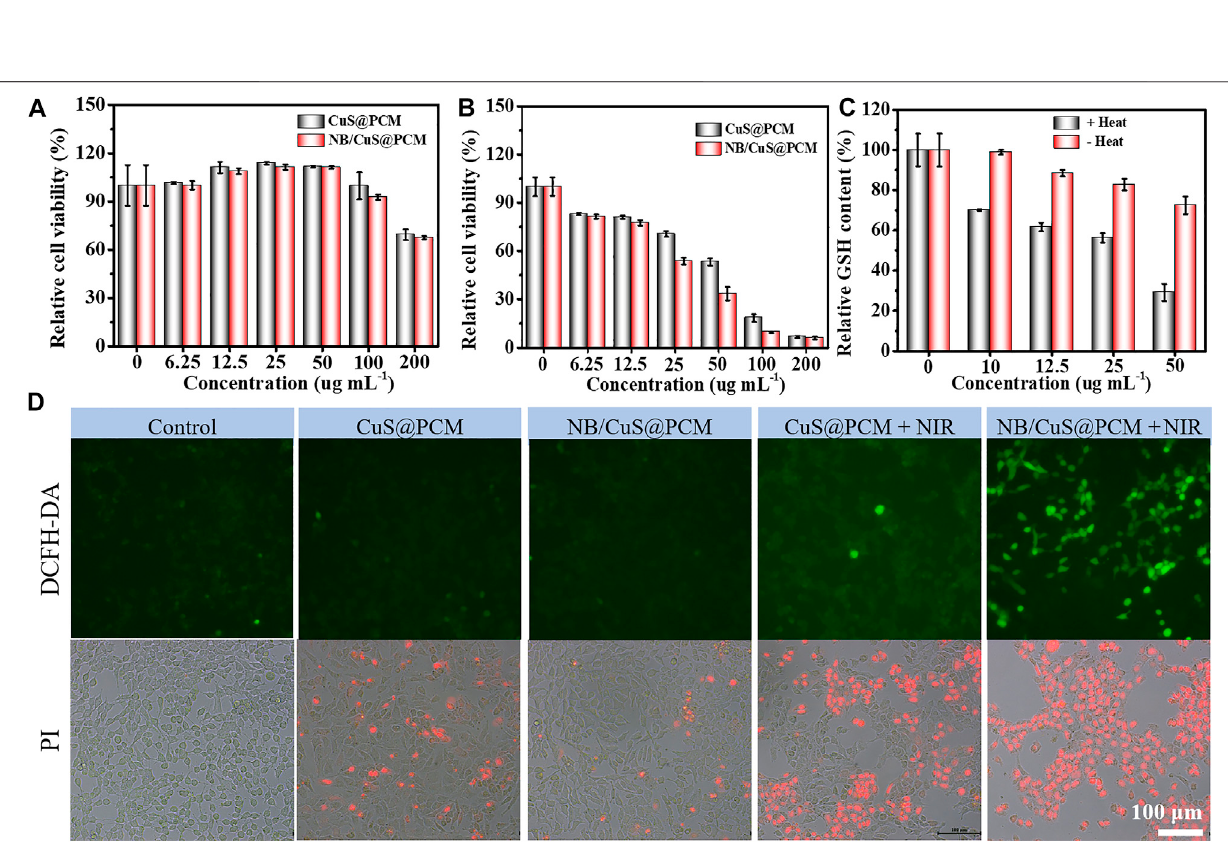
Frontiers in Bioengineering and Biotechnology |